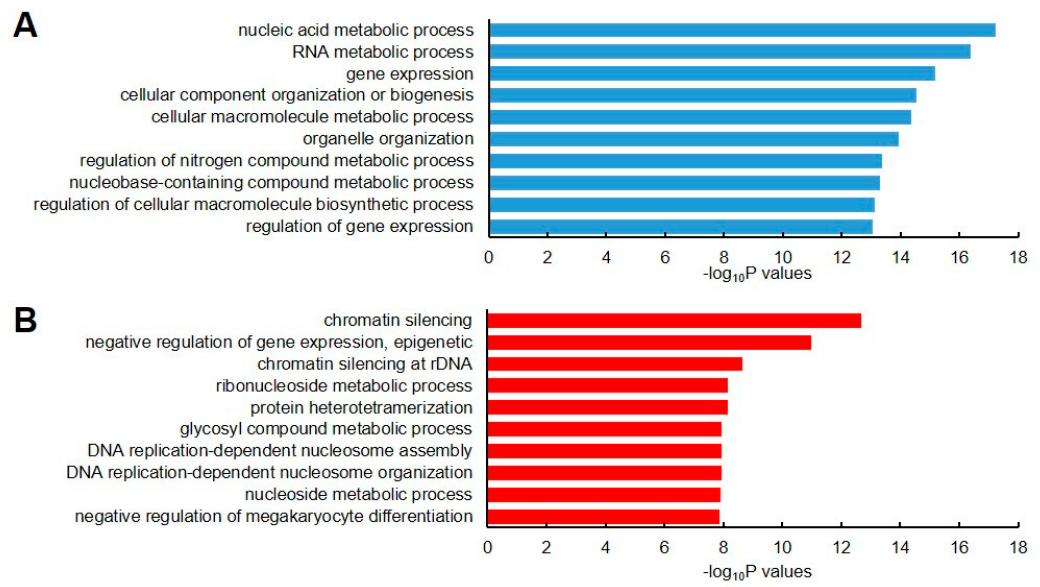
Figure 2. Gene ontology (GO) enrichment analysis of stable and unstable transcripts. The top 10 Biological Process GO terms for stable ( A ) and unstable ( B ) transcripts are represented as blue and red colors, respectively. The top 10 GO terms were selected based on their lower p -values.